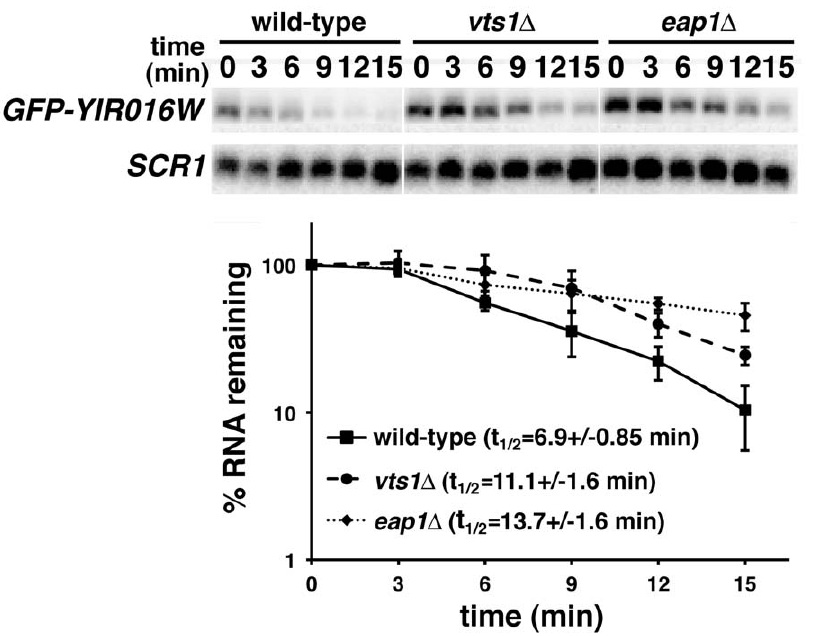
Figure 2. Eap1p is required for the destabilization of GFP-YIR016W mRNA. mRNA expression was induced in the indicated strains and then shut-off with glucose and reporter mRNA levels were assayed at the times indicated after transcriptional shutoff by Northern blot. The results of at least three independent experiments were quantitated and normalized using the levels of SCR1 RNA and graphed with error bars representing standard deviation. Note that the half-life of GFP-YIR016W mRNA is significantly increased in both vts1 D and eap1 D cells as judged by a t test (P , 0.01).